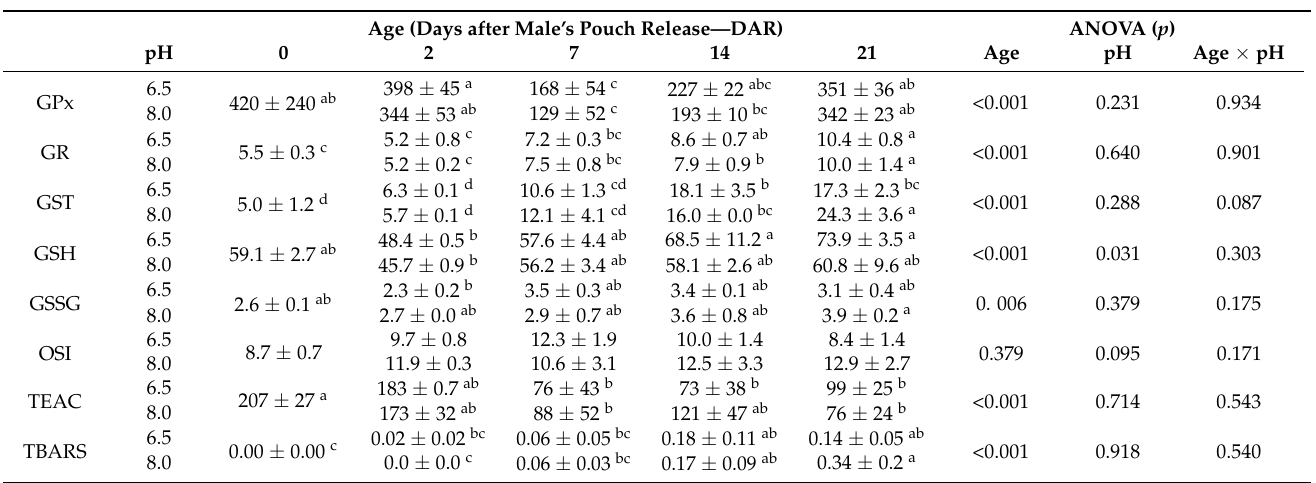
Table 5. Trial 1 (SW)—Glutathione metabolism (mean ± standard deviation) in H. reidi juveniles reared in seawater (SW—salinity 33) at pH 6.5 or 8.0 for 21 days (age 0–21 DAR—days after the male’s pouch